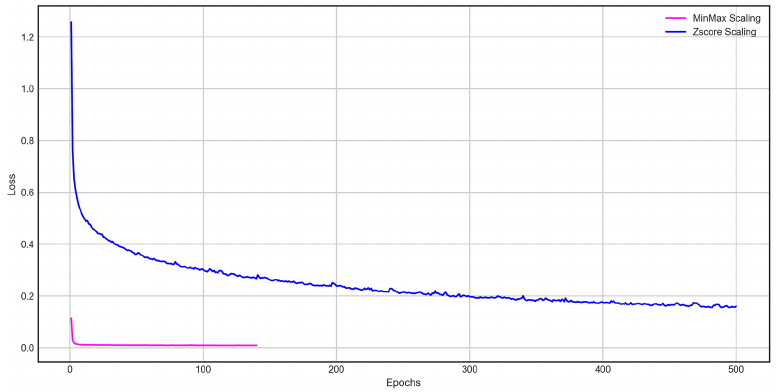
Figure 8. MinMax and Z-Score scaling (Case 3 and 4).